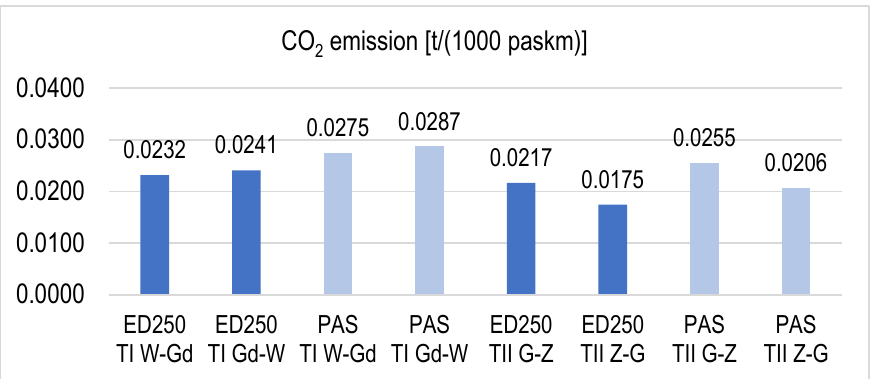
Figure 15. Comparison of specific CO 2 emissions [t/(1000 paskm)] for ED250 and locomotive train. Source: developed by the authors.